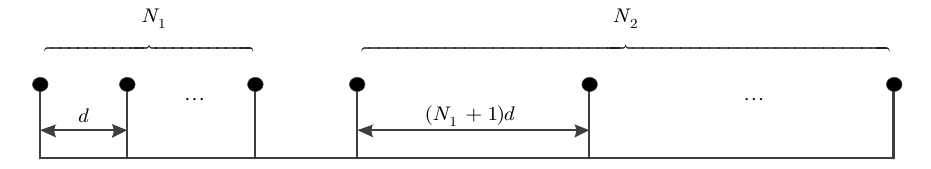
Figure 1. A 2-level nested vector-sensor array.